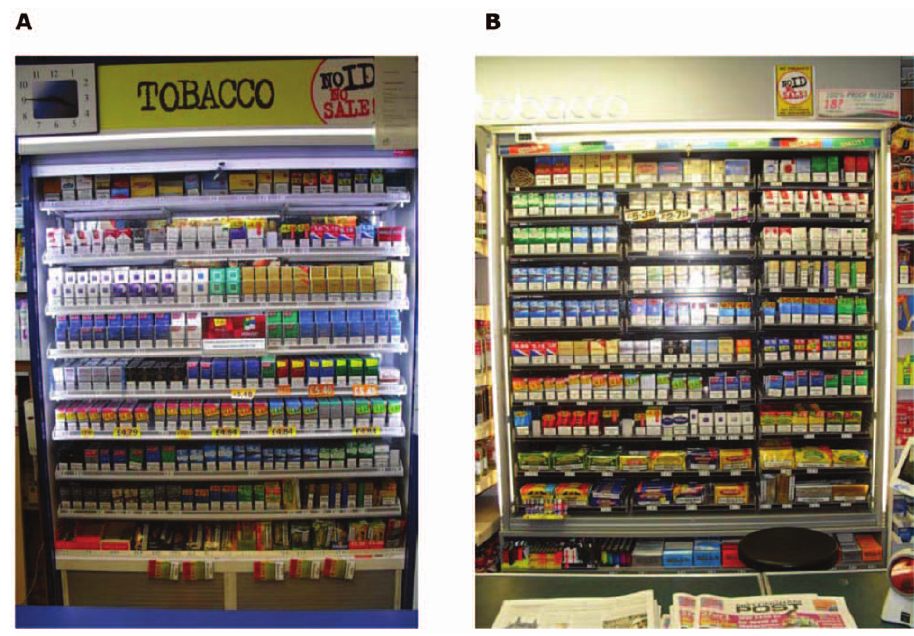
Figure 1. Examples of typical tobacco displays analysed in the study.